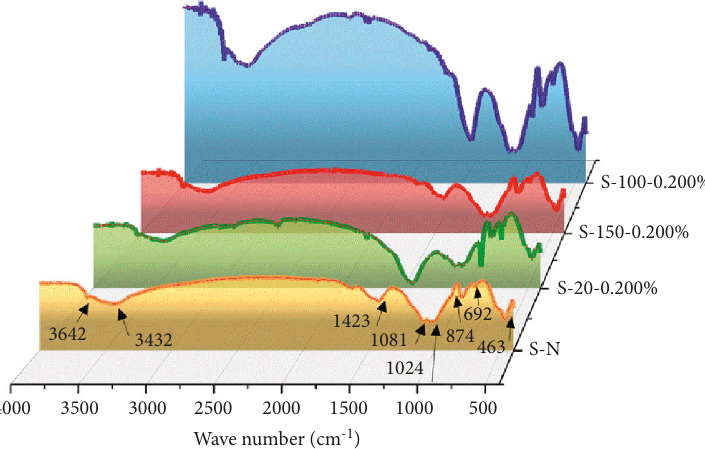
Figure 11: FTIR spectra of different particle sizes for 56 d.